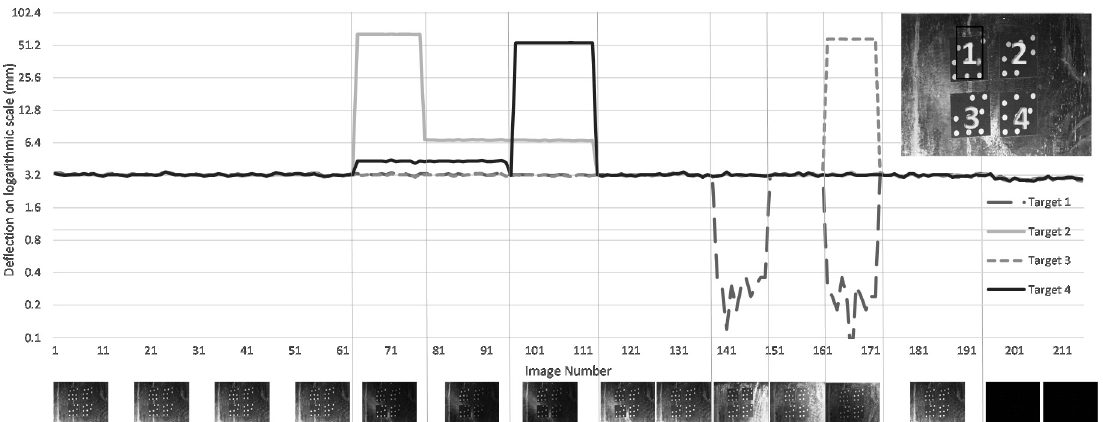
Figure 6. Effect of changes in range and incidence angle of the light source on deflection monitoring (the expected value is at 3.21 mm). The x axis is the image number while the y axis presents the deflection values. Each of the four targets in each image produced a single deflection value per picture, therefore, four lines are presenting the deflections of the four targets during this test. Also, at the bottom, sample images corresponding to x axis are presented to provide better visualization of the light conditions.